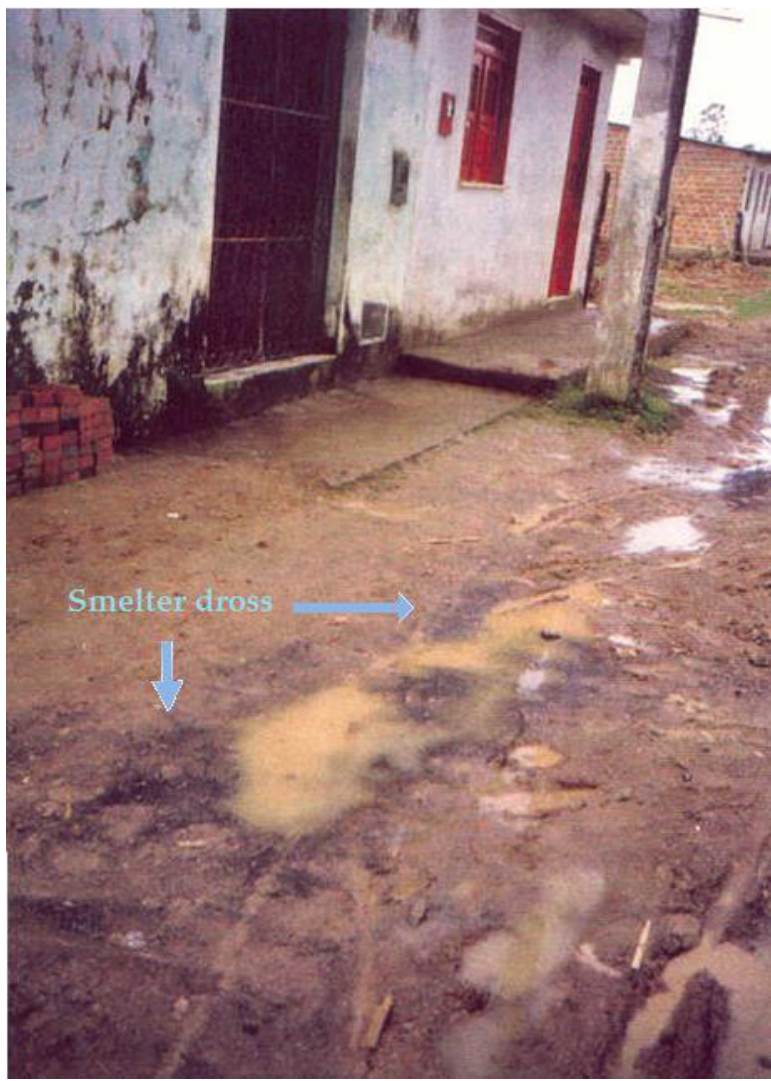
Figure 4. The dross polluting soil in front of households, 1998.